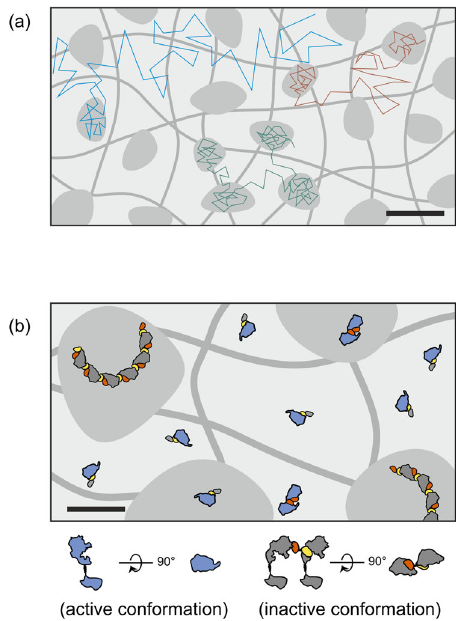
Fig. 8 Putative mechanisms of HER2 lockdown and inhibition in the plasma membrane. a Characteristic diffusion modes of HER2 monomers (cyan), dimers (red), and oligomers (green) induced by different agents are due to differential propensity of partitioning into membrane nanodomains. Schematic trajectories and transiently forming nanodomains integrated over time. Trajectory time resolution: ~5ms; hop diffusion in fl icted by the membrane skeleton omitted for clarity. Scale bar: 50nm. b Ef fi cient inhibition of HER2 by bipDARPins caused by arrest in an inactive conformation upon formation of daisy chains and by strongly enhanced partitioning of HER2 daisy chains into membrane nanodomains. Scale bar: